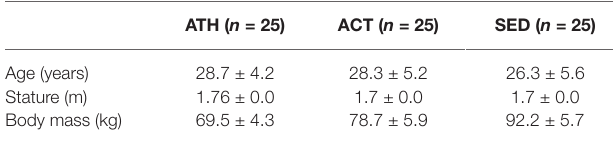
TABLE 1 | Participants’ anthropometric characteristics.